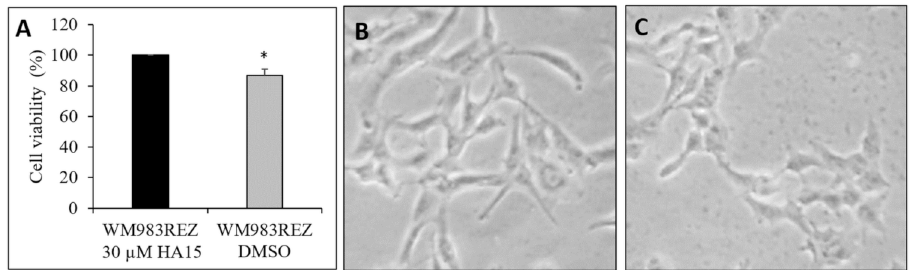
Figure 12. The effect of HA15 withdrawal on the WM983B HA15RES -resistant cell line. ( A ) Viability of the cells compared to cells grown in the presence of HA15 (black column) and after the with- drawal of the drug (grey column). The resistant cell lines were cultured in the presence of 30 µ M of HA15 or in the presence of the same volume of the solvent (DMSO). After 72 h of drug with- drawal, the WM983B HA15RES cells showed decreased cell proliferation. ( B ) Photomicrographs of the WM983B HA15RES cell line during continuous drug treatment and ( C ) after 72 h of drug withdrawal (100 × magnification). Significant differences are indicated by asterisks (* p ≤